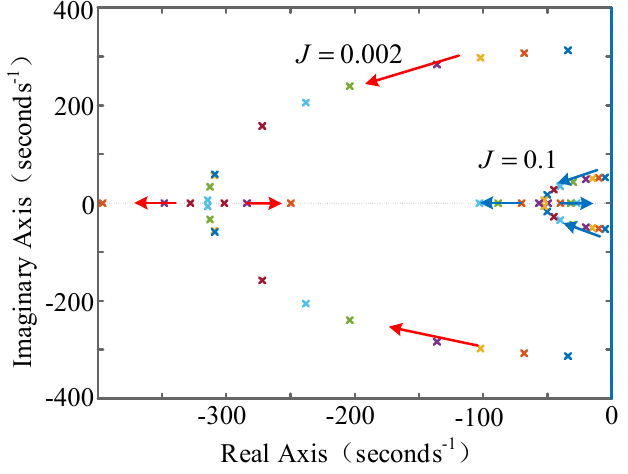
Figure 10. Root-trajectory diagram of damping coefficient and rotational inertia.